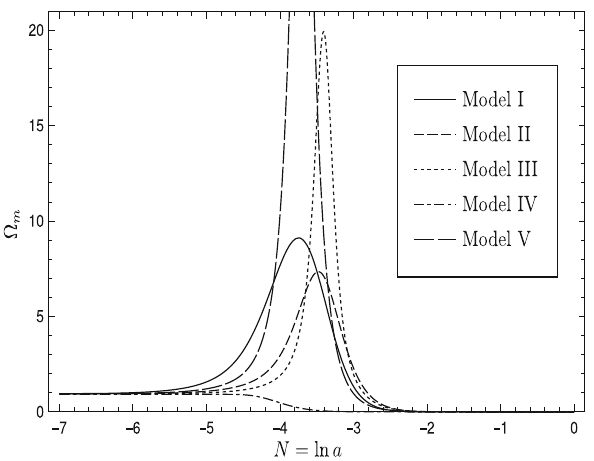
Fig. 3 Plots of (cid:10) m as a function of N for models I–V given in the table